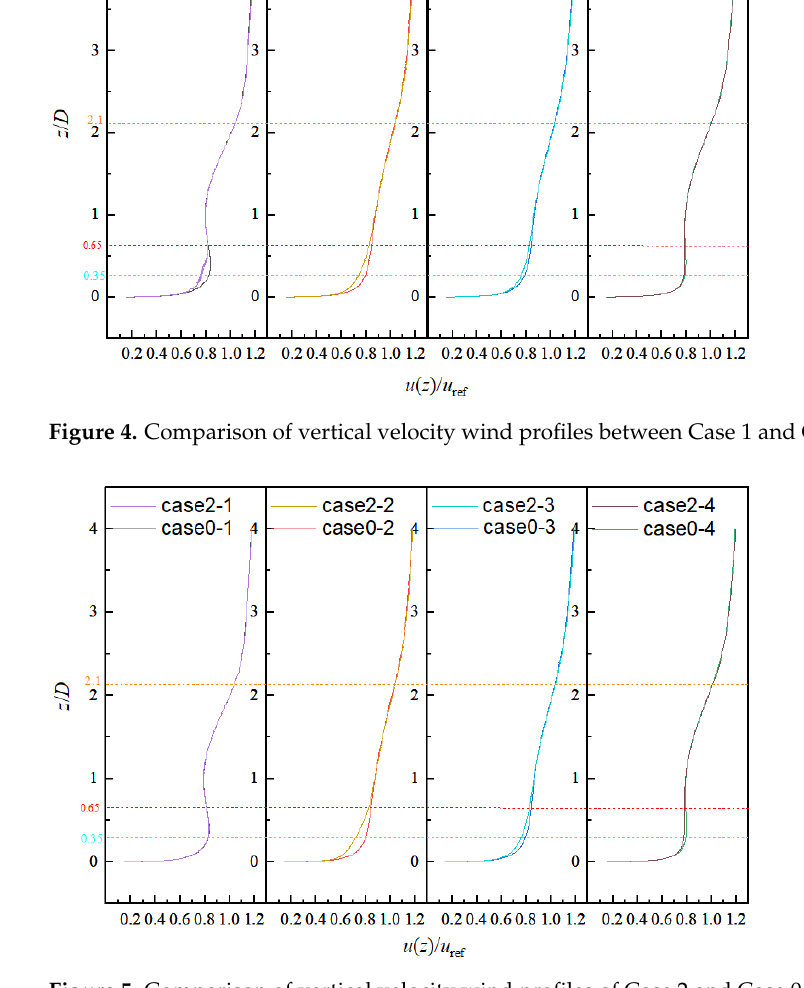
Figure 7. Comparison of vertical velocity wind profiles of Case 4 and Case 0. 3.3. Velocity Field Distribution under Different Operating Conditions We compare the power change caused by the downstream wind turbine under the influence of the small wind turbine’s wake, as shown in Figures 8 and 9. Figure 8 shows the influence of the wake of the small wind turbine on the flow field near the downstream wind turbine under different working conditions; Figure 9 shows the change in the verti- cal velocity wind profile of the flow field in front of the downstream wind turbine. A comprehensive comparison between Case 1-4 and Case 0 shows that the small wind turbine plays a certain role in improving the airflow, and its principle is similar to the deflector of vertical axis wind turbines [32]. As can be seen by the position of the white arrow in case 1 in Figure 8b, as the small wind turbine gradually approaches the down- stream large wind turbine, the air flow lifting effect generated by it gradually increases. This strengthening effect can be understood as: when there are certain obstacles in front of the wind turbine, the air flow lifting effect generated by it can better improve the in- coming speed of the wind turbine [33], while when the distance is long, this air flow lifting effect is very small, resulting in the negative impact of the turbulent wake of the small wind turbine taking the dominant position.